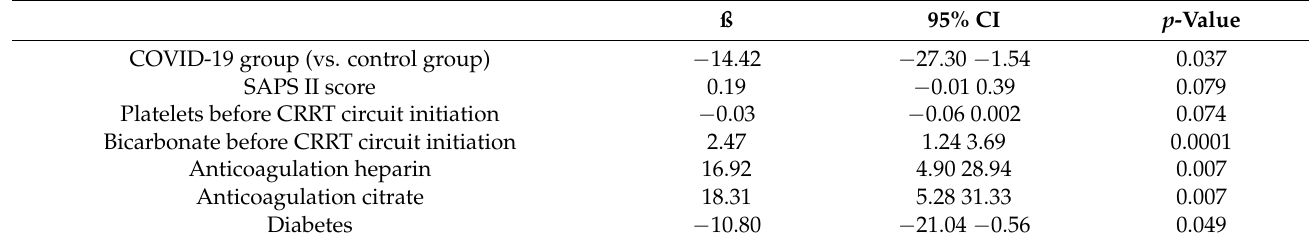
Table 3. Associated variables with filter